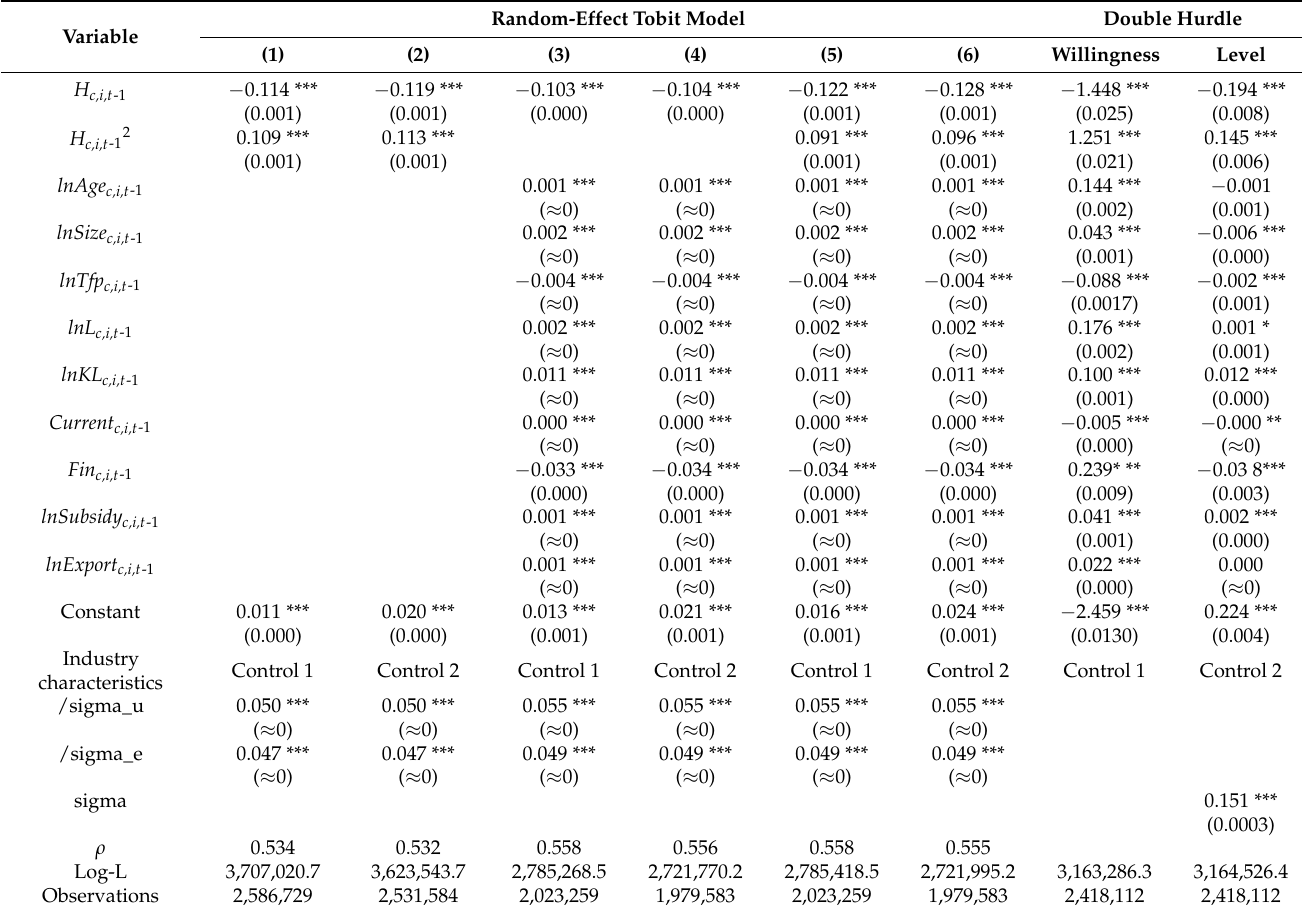
Table 4. Environmental compliance and enterprise innovation: Benchmark